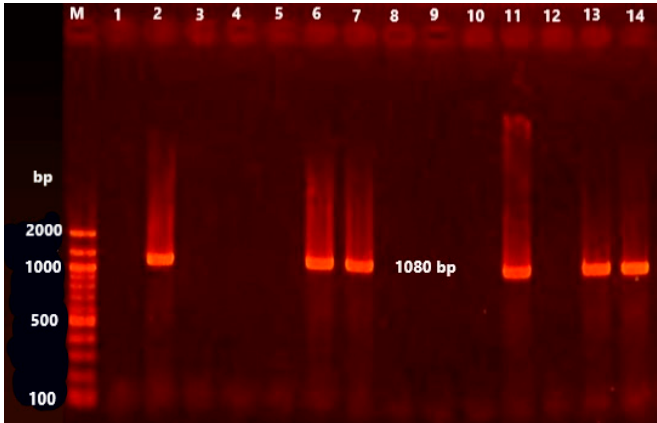
Figure 2. Electrophoresis pattern on agarose gel (1.0%) made by the amplicons for the bla TEM genes (1080 bp). Lane M is a 100 bp ladder as a molecular size standard. Lanes 2, 6–7, 11, 13, and 14: positive isolates. Lanes 1, 3–5, 8–10, 12: negative isolates.